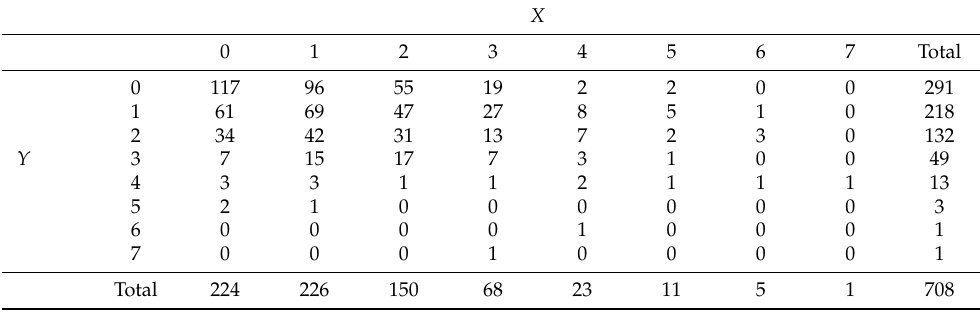
Table 9. Real data of X accident number in a period and Y of another